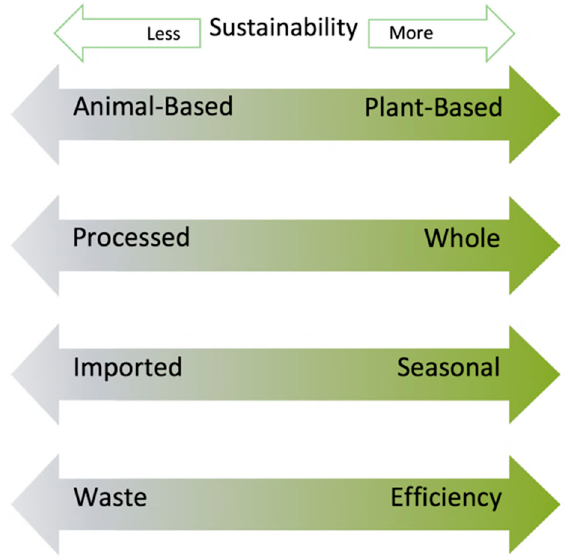
Figure 1. Characteristics of foods in a diet that determines its sustainability. The graphic illustrates that a sustainable diet has a higher proportion of foods that are plant-based, whole, in-season, and consumed with no or minimal waste [18].